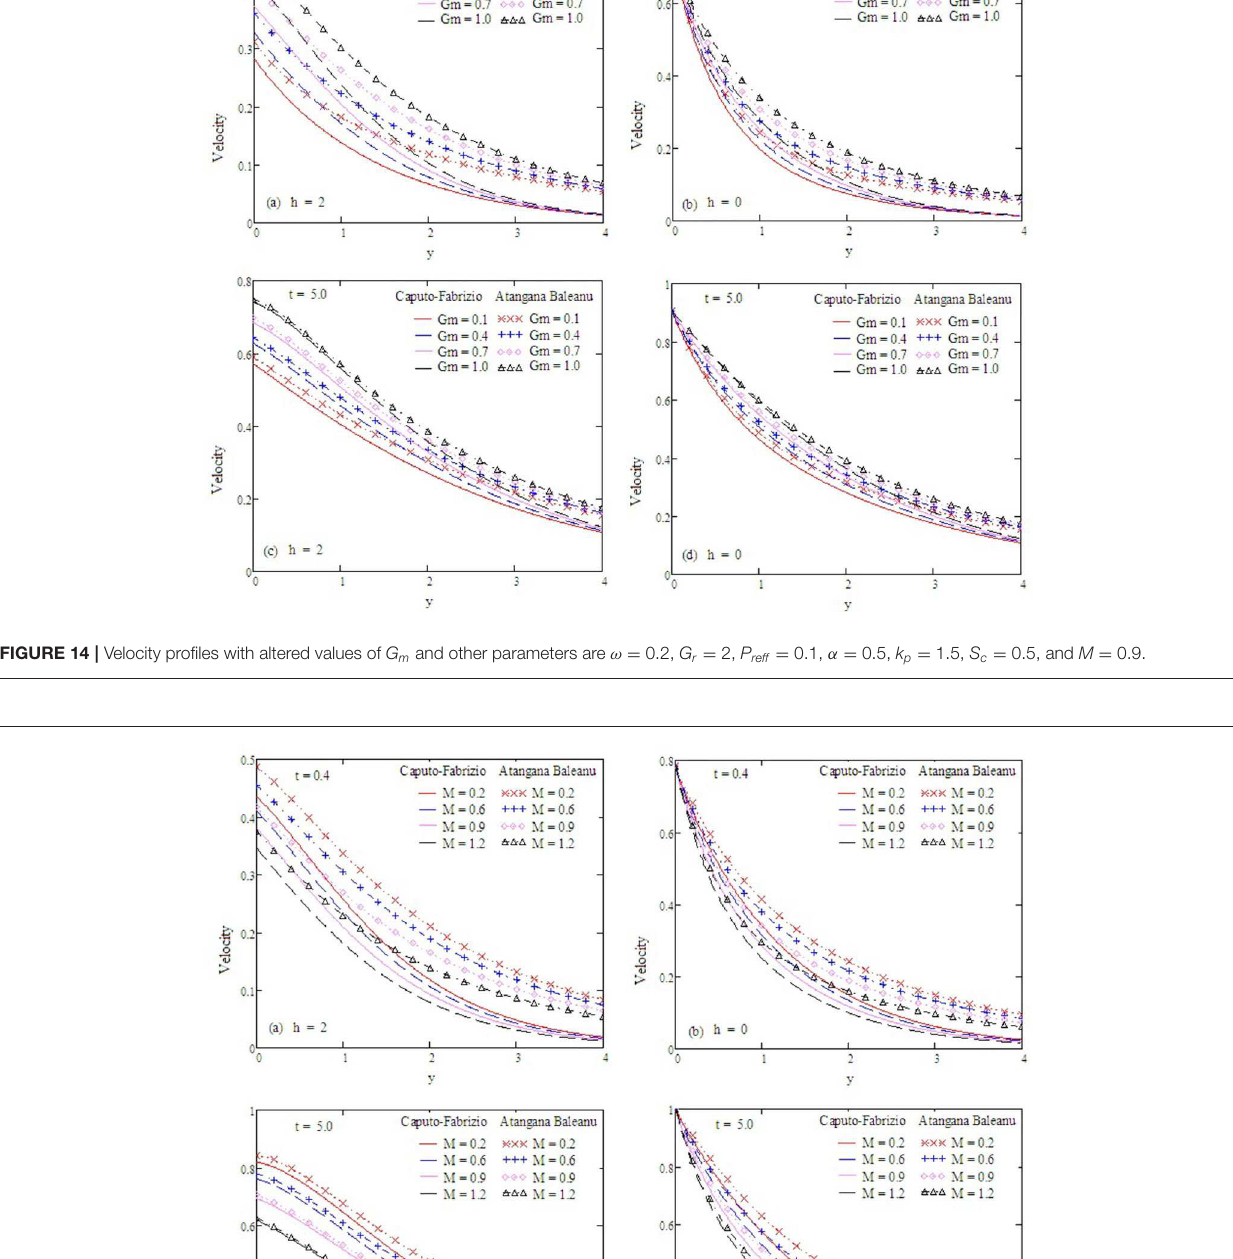
FIGURE 15 | Velocity profiles with altered values of M and other parameters are ω